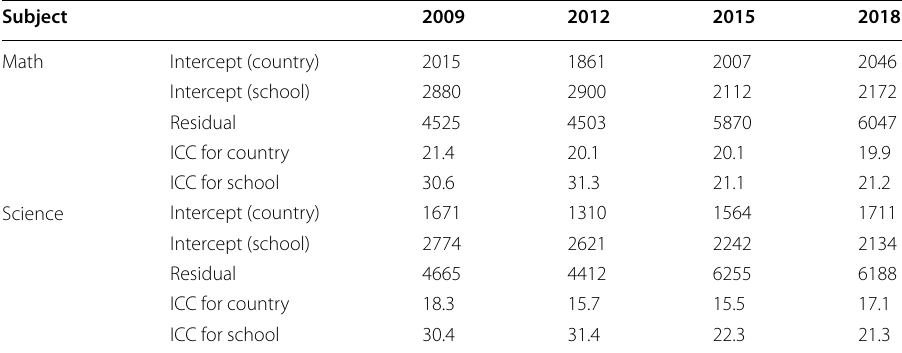
Table 2 Intraclass correlation coefficients for math and science from 2009 to